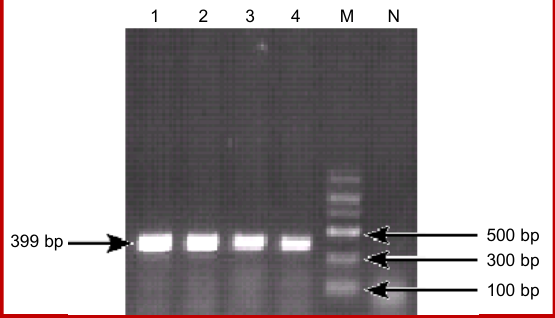
Figure 1: Agarose gel electrophoresis of the products of PCR . Lanes 1-4, samples; M, molecular weight markers (Beijing SBS Genetech Co., Ltd, China); N, represents the negative control without DNA